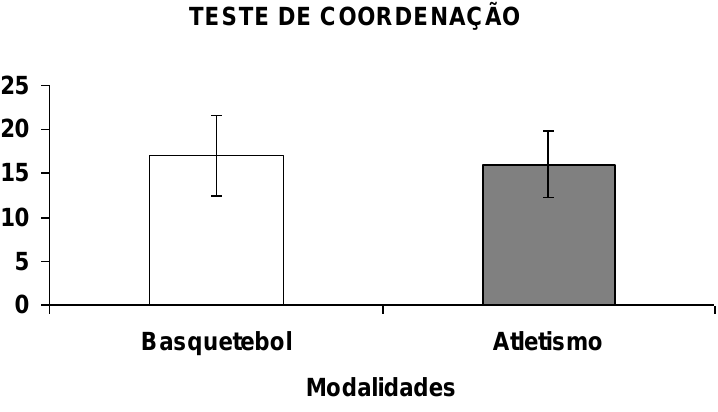
Figura 1. Média e desvios Padrão dos escores de coordenação entre as modalidades esportivas presentes neste